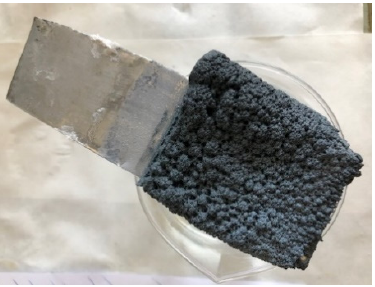
Figure 9. A photo documentation of the zinc product segregated on a stainless plate after electrol- ysis—sample H22. Condition at the electrolysis: cathode—stainless plate, anode—nickel plate,